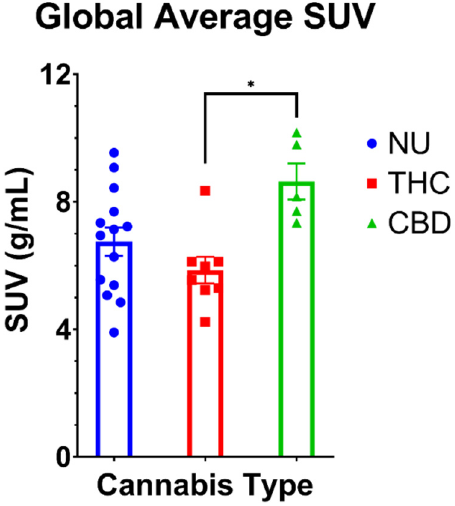
Figure 1. Comparison of volume-weighted global average SUVs for cannabis non-users (NU), THC